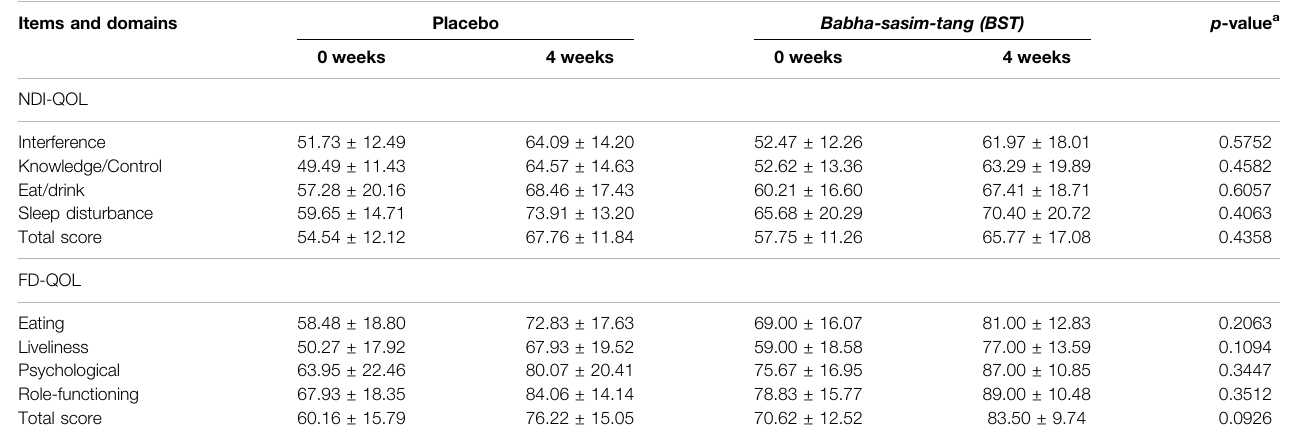
TABLE 3 | Quality of Life (QoL) scores using NDI and